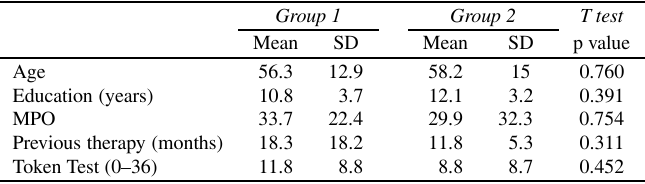
Table 2 Comparison of mean age, education, MPO, previous therapy (months) and